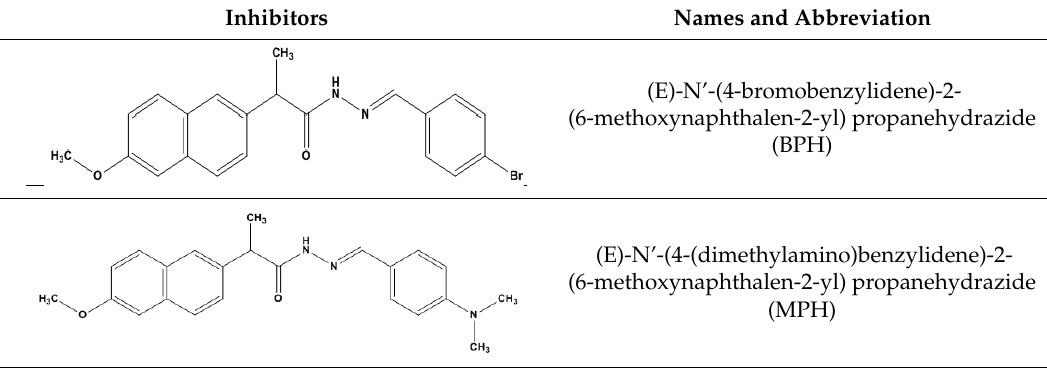
Table 1. Chemical composition of the studied mild steel (MS). Table 2. Molecular structures of (E) ‐ N’ ‐ (4 ‐ (dimethylamino) benzylidene) ‐ 2 ‐ (6 ‐ methoxynaphthalen ‐ 2 ‐ yl) propanehydrazide (MPH) and (E) ‐ N’ ‐ (4 ‐ bromobenzylidene) ‐ 2 ‐ (6 ‐ methoxynaphthalen ‐ 2 ‐ yl) propanehydrazide (BPH).